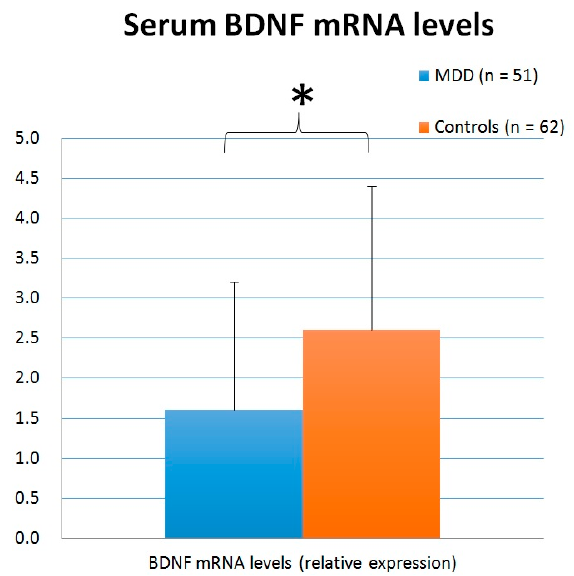
Figure 4. Serum BDNF mRNA levels (relative expression) in patients with MDD and the healthy controls. (* p < 0.05)